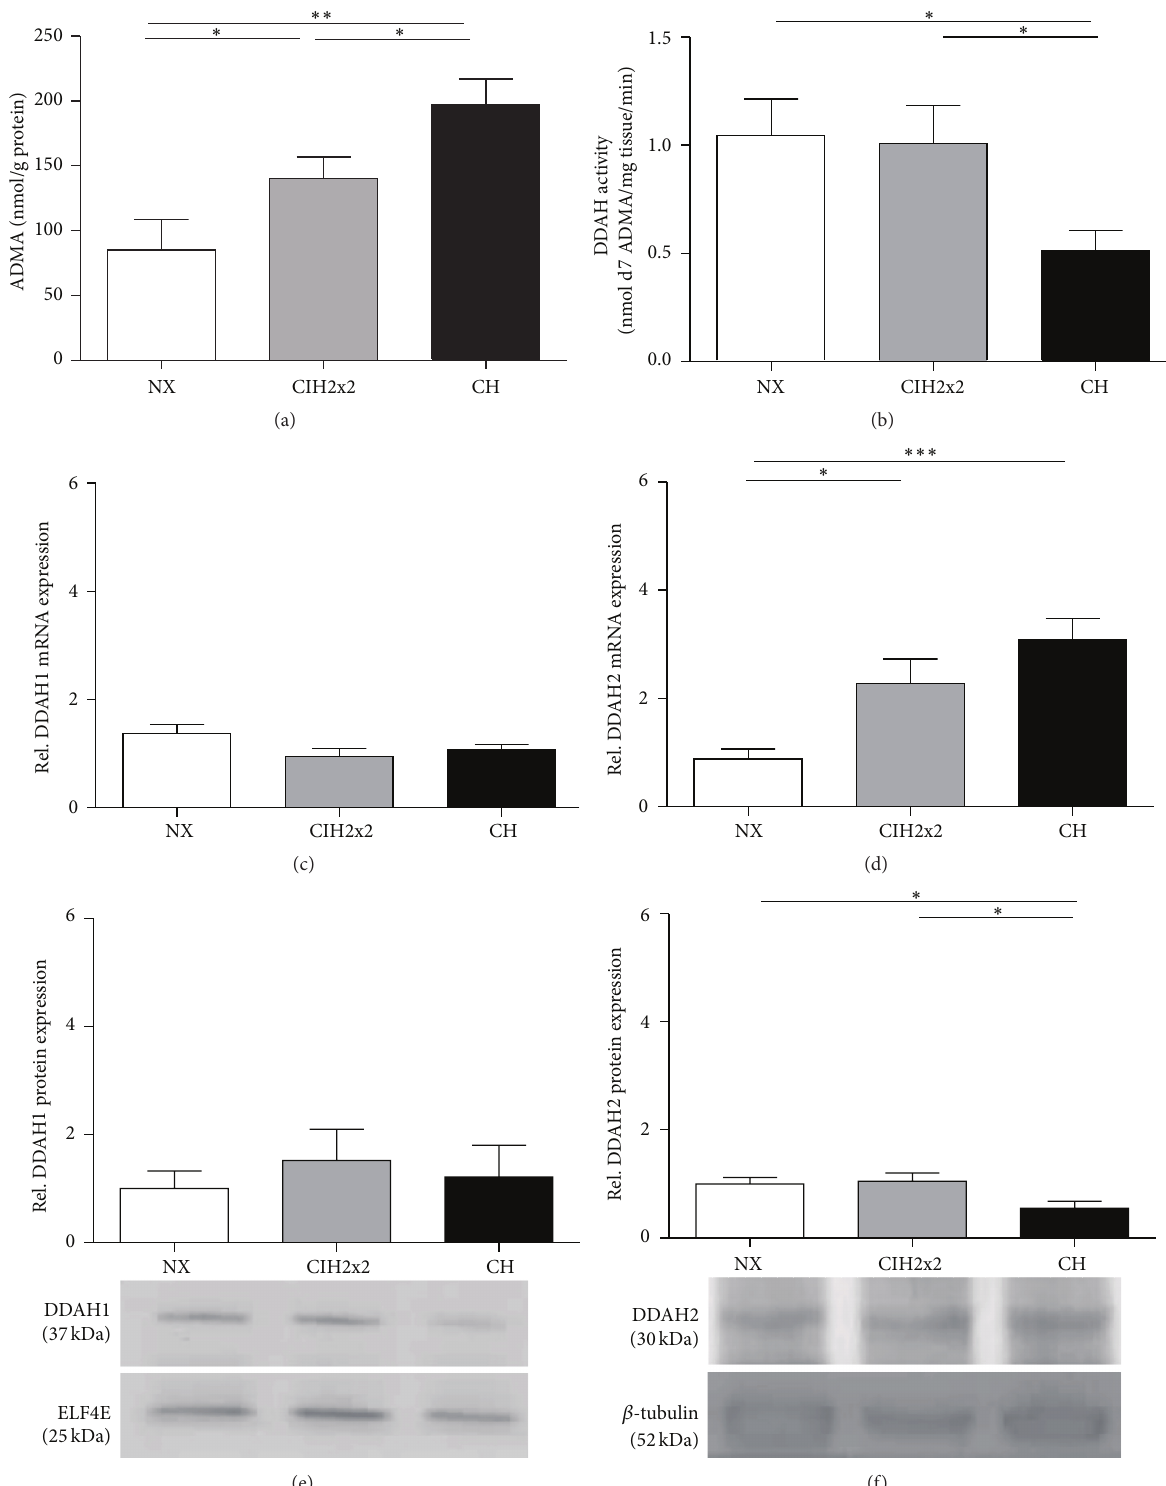
Figure 4: Comparison of (a) ADMA concentrations (nmol/g protein) determined by LC-MS/MS assays, (b) DDAH enzyme activity (nmol d7 ADMA/mg tissue/min) determined by LC-MS/MS assays, (c) mRNA expression of DDAH1 determined by qRT-PCR, (d) mRNA expression of DDAH2 determined by qRT-PCR, (e) DDAH1 protein expression levels determined by western blot, and (f) DDAH2 protein expression levels determined by western blot. Respective representative bands on western blots of lung tissue from rats exposed to normoxia (NX), chronic intermittent hypoxia (CIH2x2), or chronic hypoxia (CH) are presented. Values are expressed as means and SE. ∗ 𝑝 < 0.05 ; ∗∗ 𝑝 < 0.01 ; ∗∗∗ 𝑝 < 0.001 ; 𝑛 = 8 in each